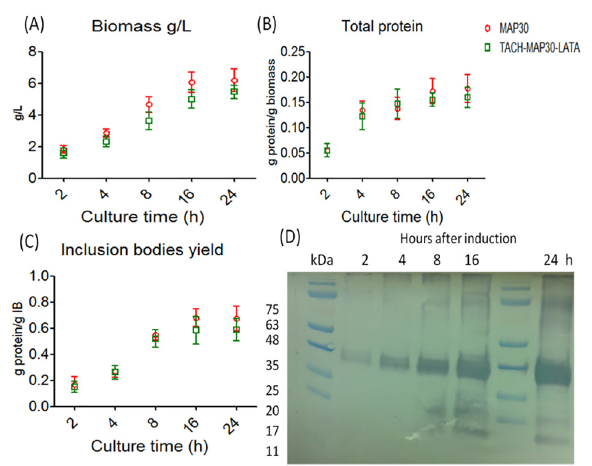
Fig 2. Production of the recombinant peptide-fusion protein (TACH- MAP30-LATA) and MAP30 by a recombinant E . coli . A) Total dried biomass of E . coli after the chemical induction at all of the time points of the fermentation process. B) Relative total recombinant protein to the biomass of TACH-MAP30-LATA and MAP30. C) Recombinant protein yield from inclusion bodies. D) Western blot analysis of the purified recombinant peptide-fusion protein at each time point of the fermentation process (Two Way-ANOVA, p >